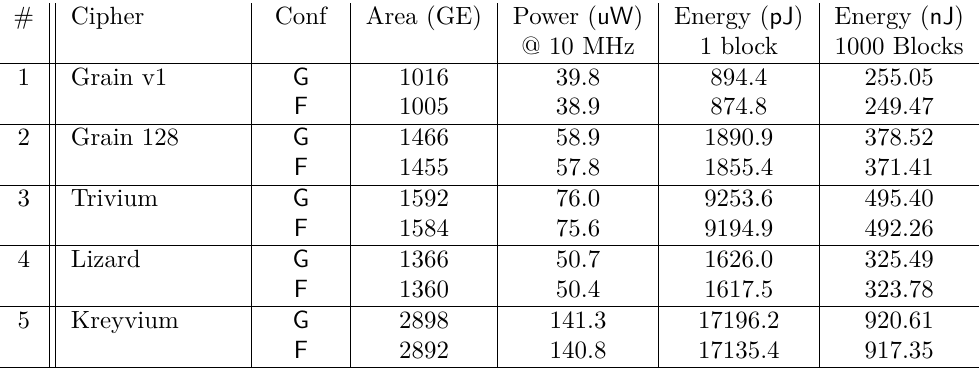
Table 2: Results for Fibonacci vs Galois configurations, 1 block=64 bits, G : Galois, F : Fibonacci